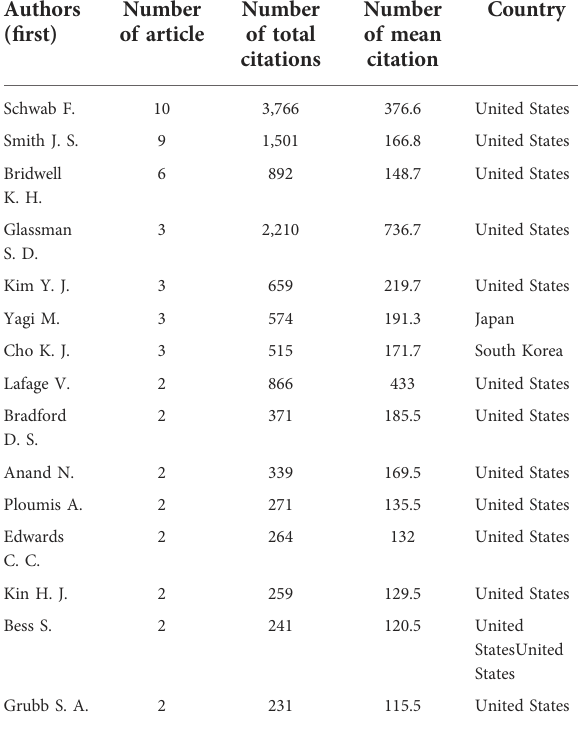
TABLE 2 First authors with two or more papers of the 100 most-cited articles on adult spinal deformity. Authors ( fi rst)